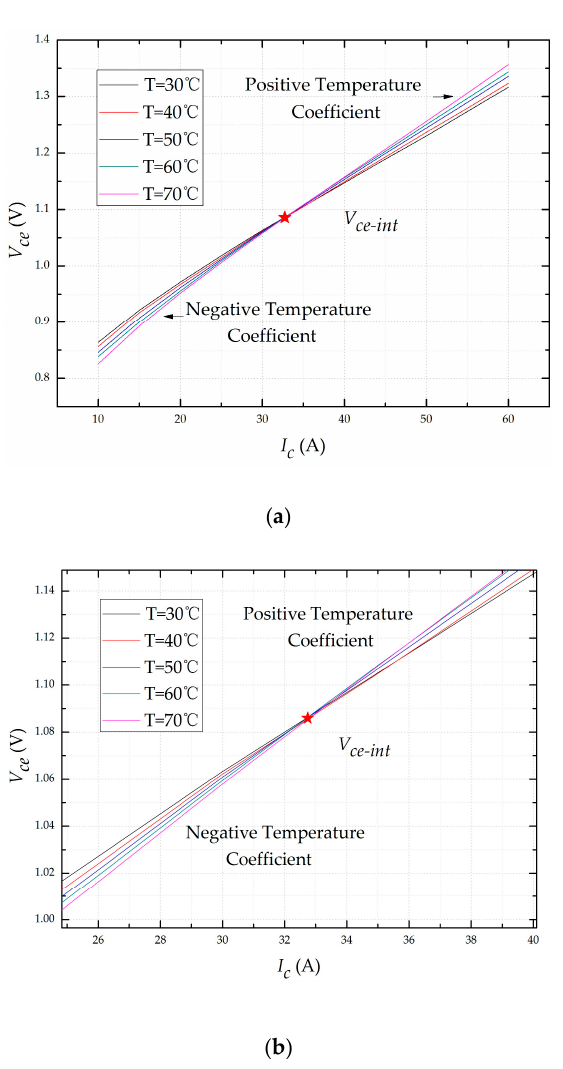
Figure 1. Relationship between on-state voltage ( Vce ) and junction temperature ( T j ): ( a ) The complete characteristic curves; ( b ) the enlarged view near an intersection point ( V ce-int ).